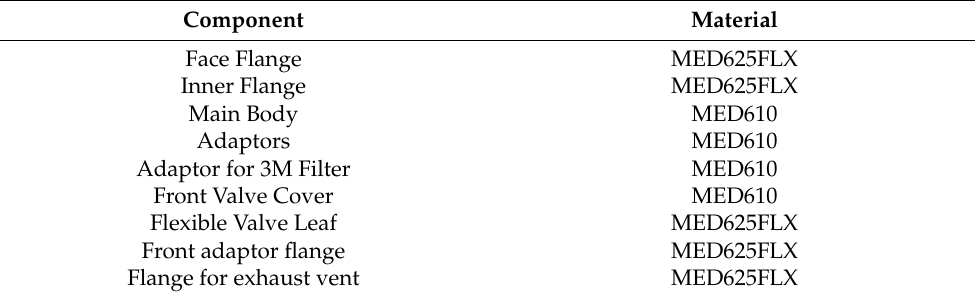
Table 1. Assigned material per mask component.